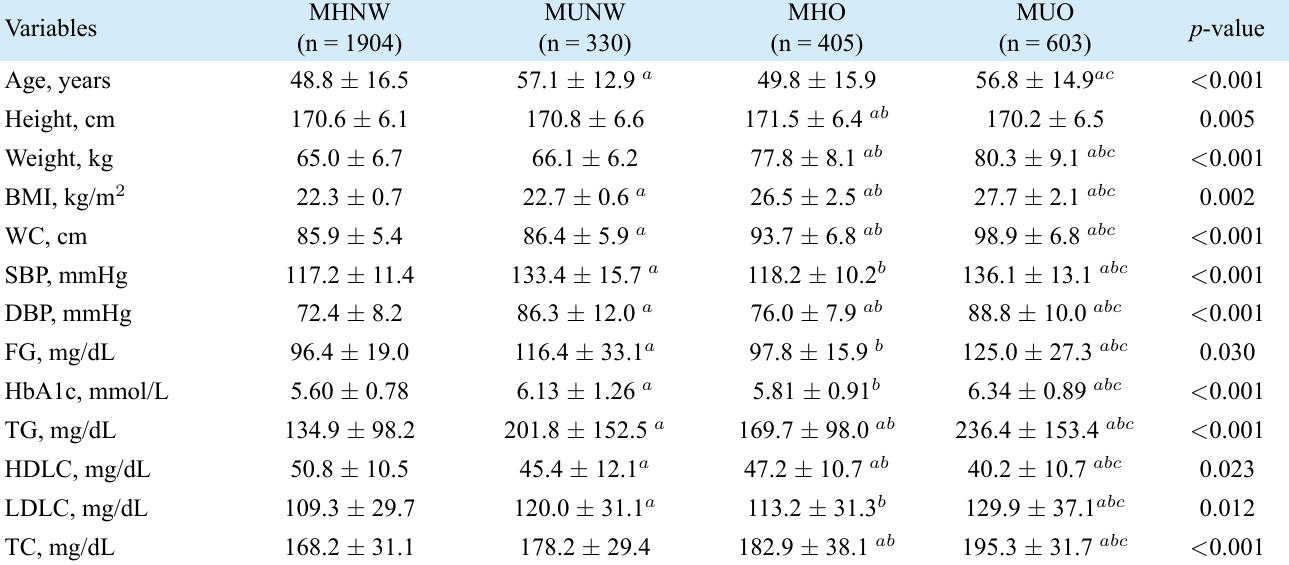
TABLE 2. Physical and clinical characteristics by obesity